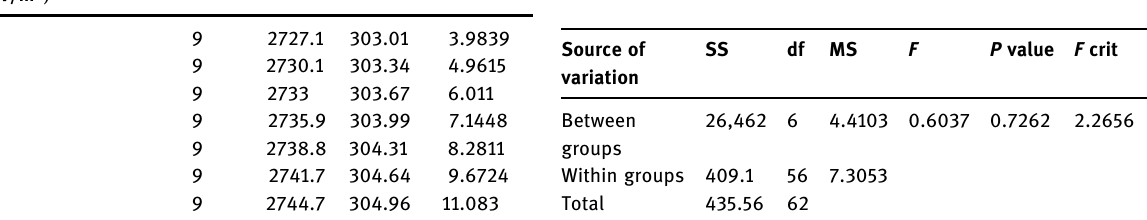
Table 8: ANOVA heat generation rate on variations in the shape